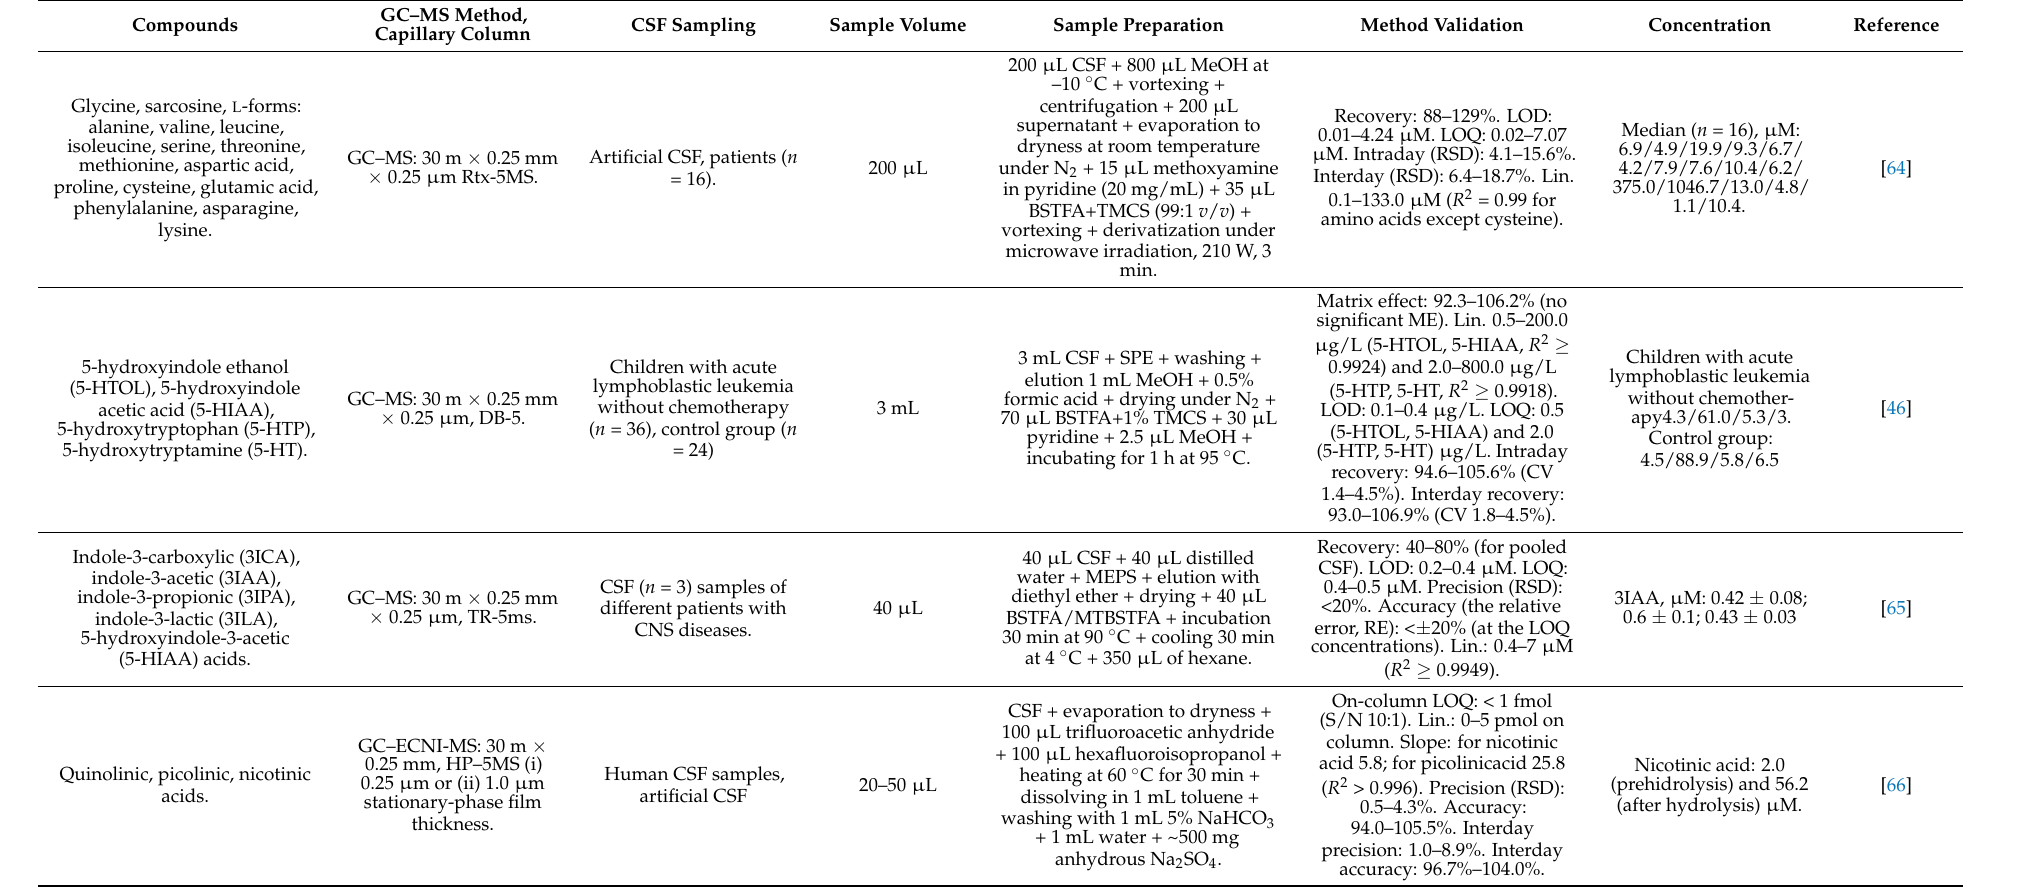
Table 3. The analytical methods for the determination of the low-molecular-weight compounds in the CSF using GC–MS methods. Compounds Method Validation